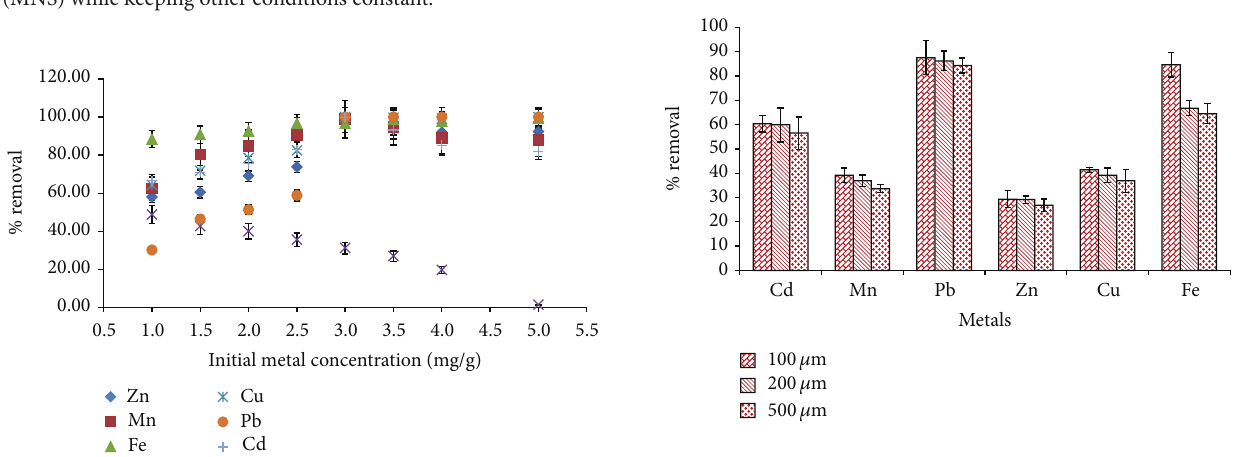
Figure 11: Effect of particle size on metal removal using